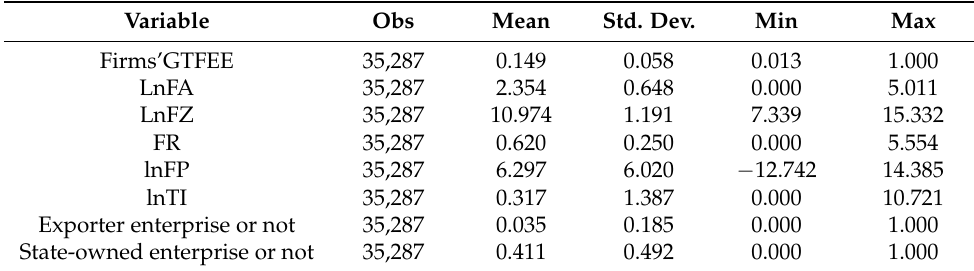
Table 3. Descriptive